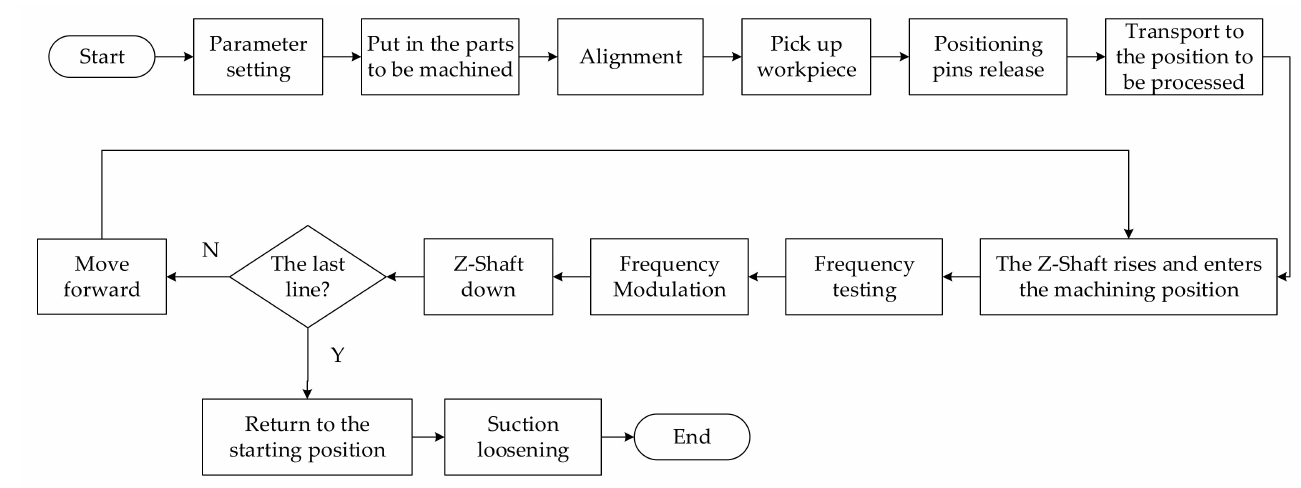
Figure 3. Automatic operation flow chart of laser process for MCR frequency